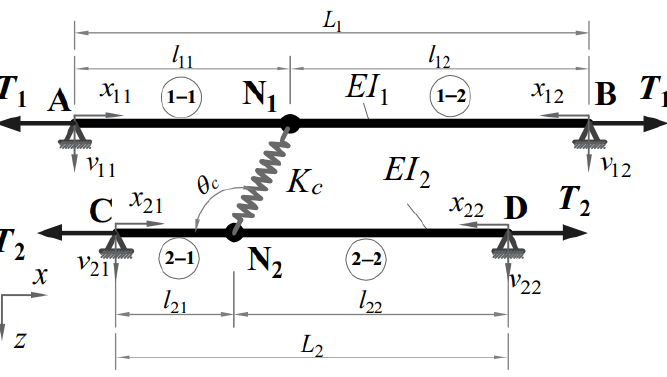
Figure 3. Network cables modeled as two simply supported cables and a flexible cross-tie.